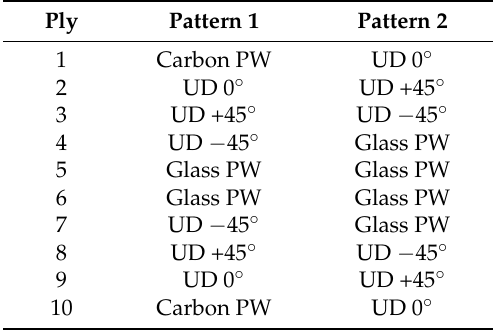
Table 2. Description of the stacking sequences for thermoforming